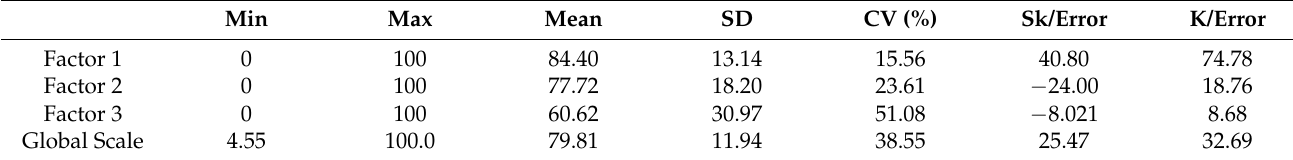
Table 8. Statistics concerning the Mental Health Knowledge Questionnaire.